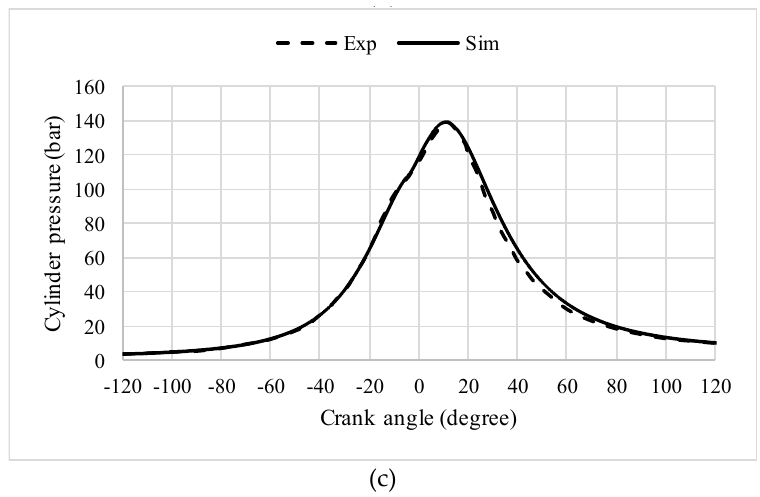
Figure 7. Pressure diagram at ( a ) 25% load; ( b ) 50% load; ( c ) 75% load at 1200 RPM.